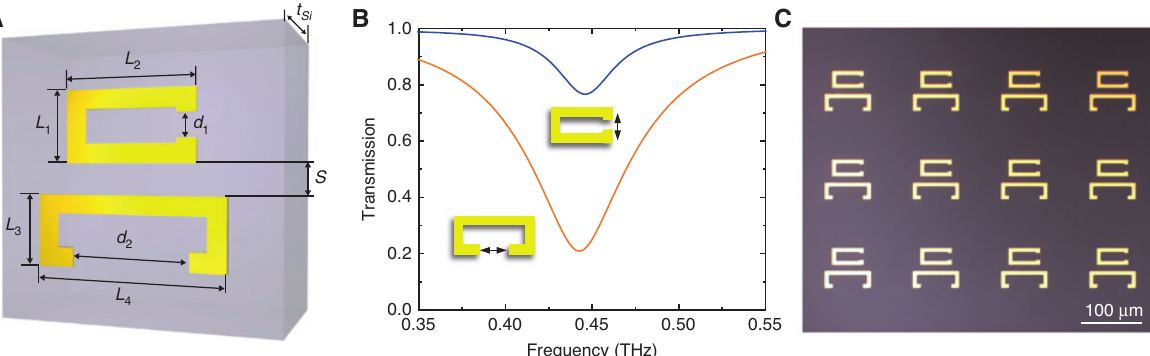
Figure 1: Structure of the non-Hermitian metasurface with the transmission spectrum of its resonator components. (A) Schematic of the unit cell geometry. Dimensions are set to L dimensions of each SRR are optimized such that they have an equal resonance frequency while having different gap sizes. The difference in gap size makes the transmission matrix dispersive, thus letting us control the eigenstates of the system by changing the frequency of incident radiation. (B) Independent transmission plots for the orthogonally oriented SRRs in the unit cell. Each SRR was excited by incident radiation polarized parallel to the gap direction. (C) Top-view microscopic image of the fabricated